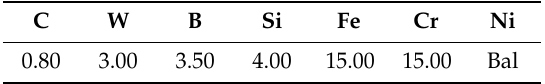
Table 2. Chemical composition of Ni60 powder (wt %).